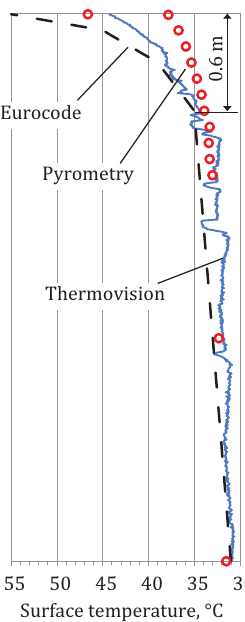
Figure 12. Comparison of results from thermovision and pyrometry with the model of Eurocode, 26 June 2019, time 13:30, in relation of girder